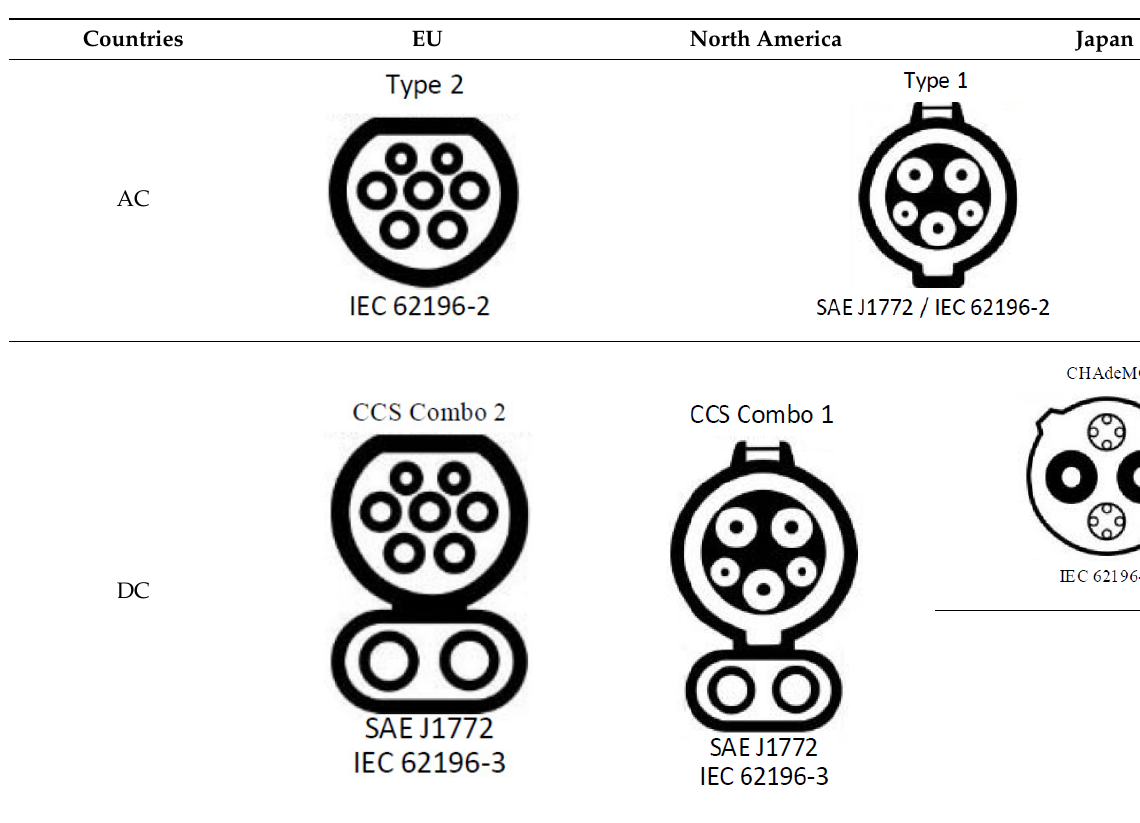
Table 5. EV charging Inlet classifications by region.